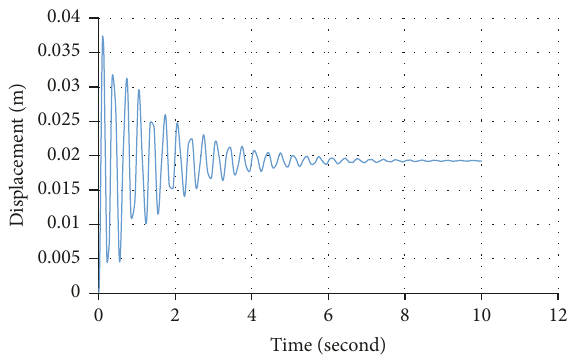
Figure 9: The displacement of middle column upper node versus time in dynamic model.